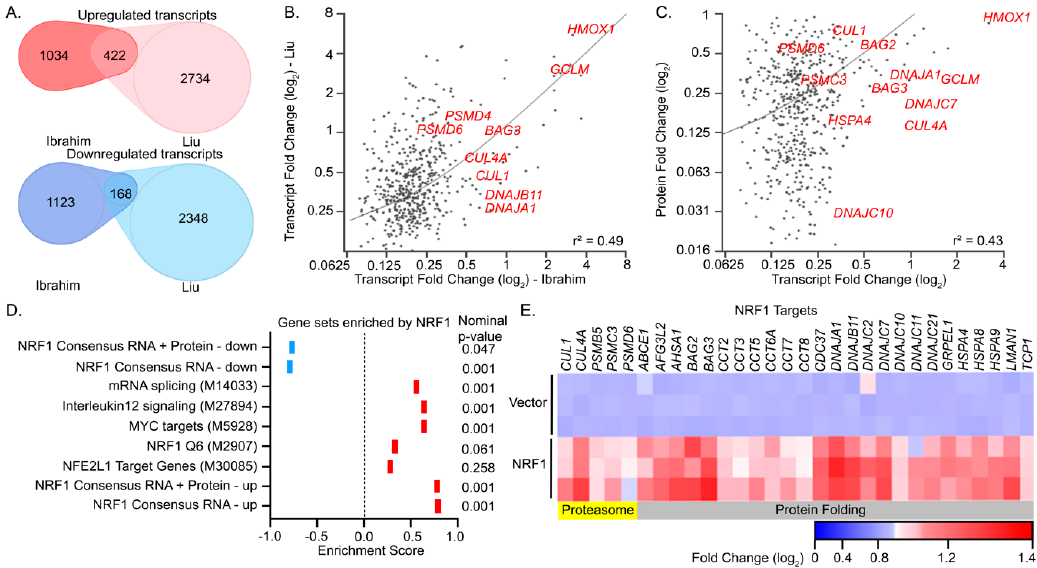
Figure 5. A consensus set of NRF1 target genes associated with proteostasis. ( A ) Venn diagram depicting the overlapping and differentially expressed transcripts induced by NRF1 activation identified in this work (Ibrahim, p < 0.05 and absolute value of log 2 fold change > 0.075) in comparison to those obtained with reported inducible U2OS-based system (Liu et al.). ( B ) Plot depicting the linear relationship of differentially expressed transcripts derived from the common NRF1 targets in this work and from Liu et al. ( C ) Linear regression plot of log 2 fold change values of protein and transcript levels of significantly altered genes in response to NRF1 overexpression. ( D ) Summary of GSEA analysis of RNA-seq profiling in response to NRF1 overexpression ( E ) Heatmap depicting log 2 fold change of transcript levels associated with proteostasis that are upregulated by NRF2 overexpression by DAVID analysis.